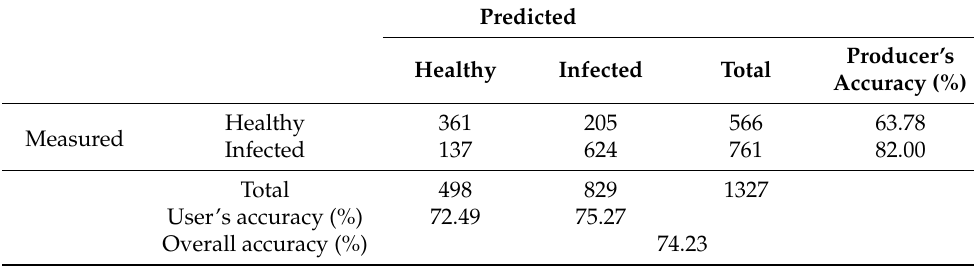
Table 3. Results (confusion matrix) of Method-SSA.